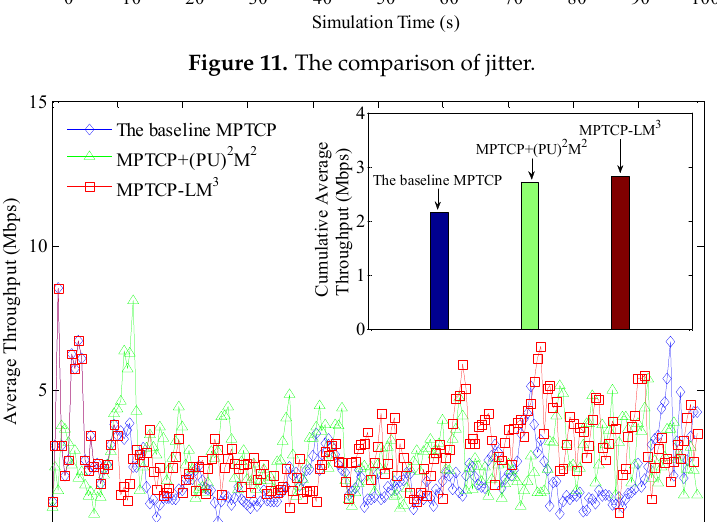
Figure 11. The comparison of jitter.